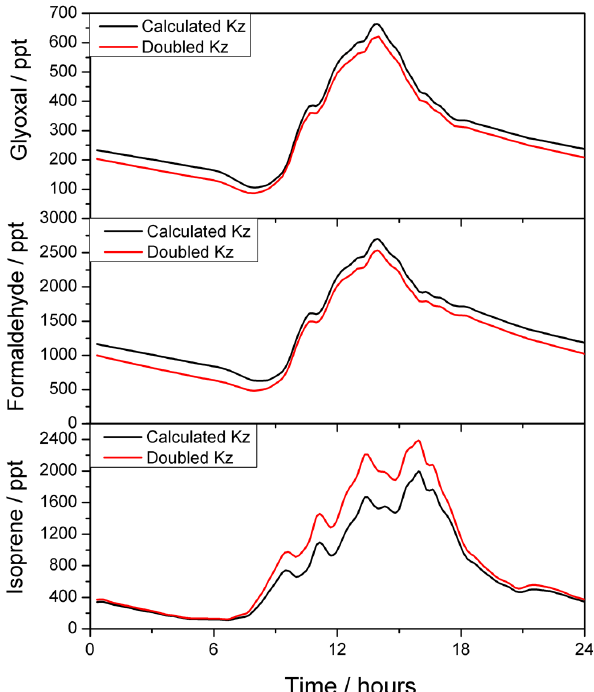
Fig. 12. Modelled diurnal profiles for glyoxal, formaldehyde and isoprene using the estimated K z profile (black line, see text for de- tails) and double that value (red line).